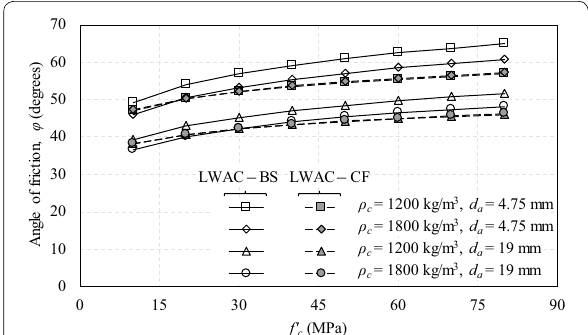
Fig. 8 Comparisons of φ values between LWAC‑BS and LWAC‑CF.